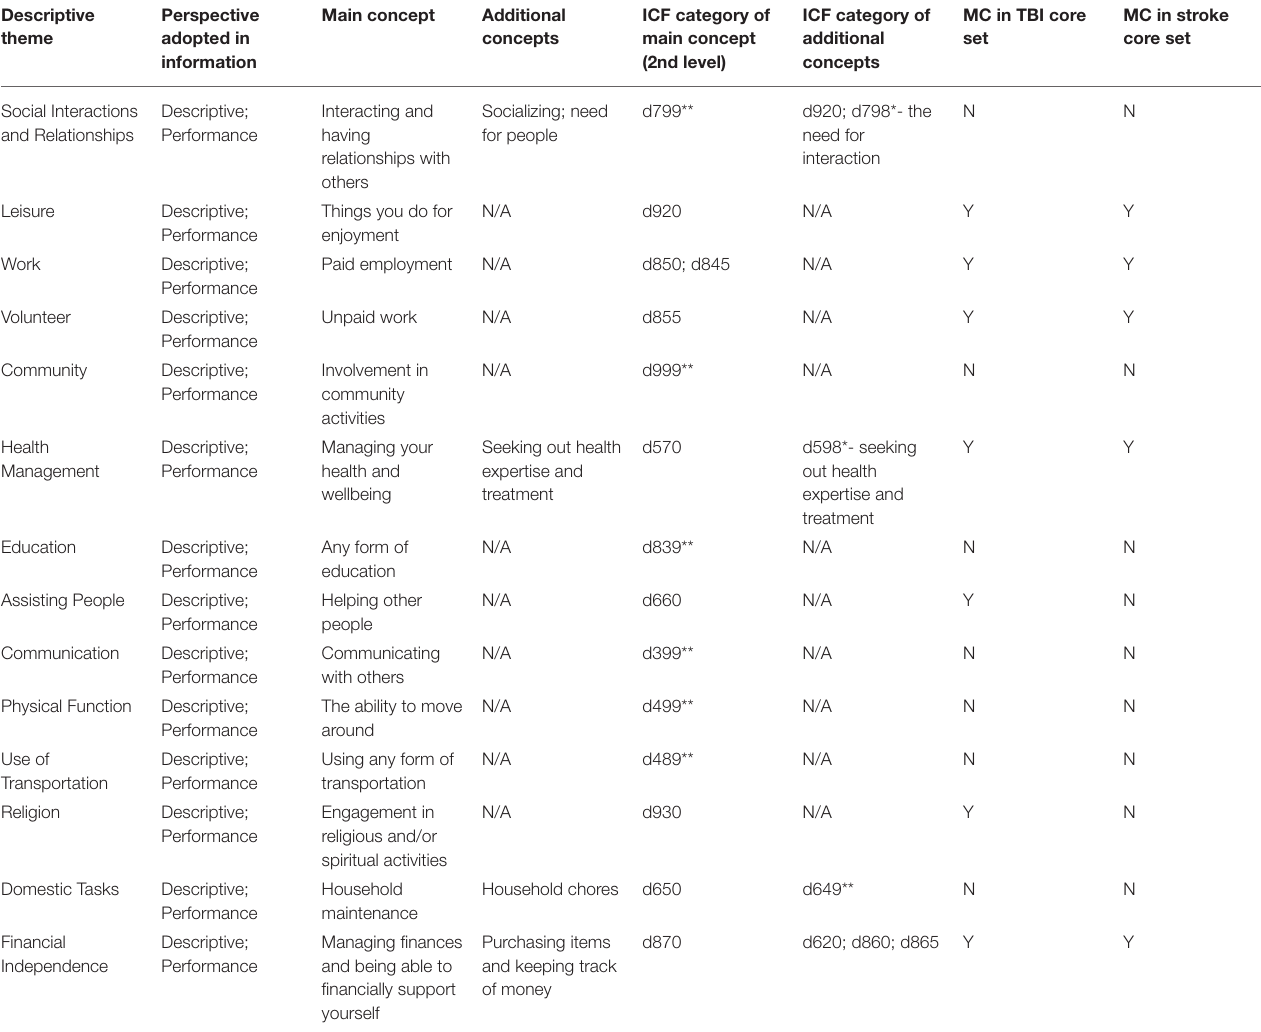
TABLE 7 | ICF linking to themes from where pwABI participate. Descriptive